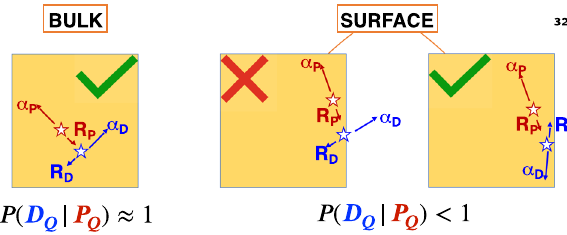
Fig. 4 Sketch of α − α delayed coincidences for bulk (left) and surface (right) crystal contaminations. Parent and daughter decays are repre- sented in red and blue, respectively. In the bulk case, there is nearly a 1:1 ratio between detected daughter events and parent candidates. This ratio falls below 1, when contaminations are on the detector